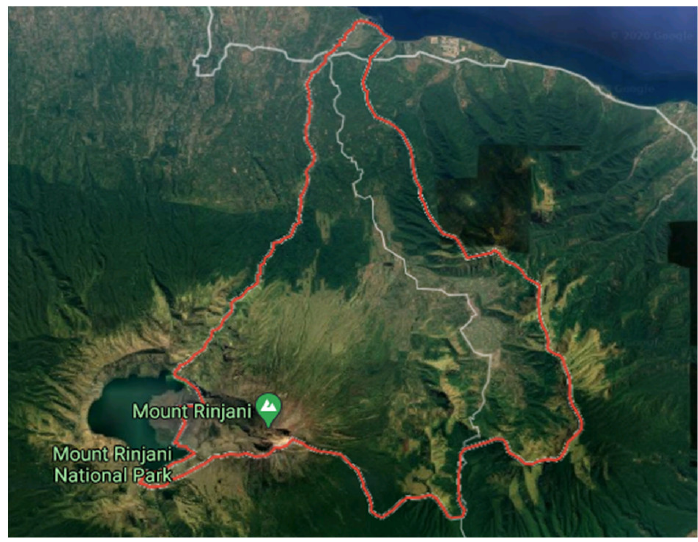
Figure 2. Satellite image of Sembalun District, East Lombok, Indonesia.